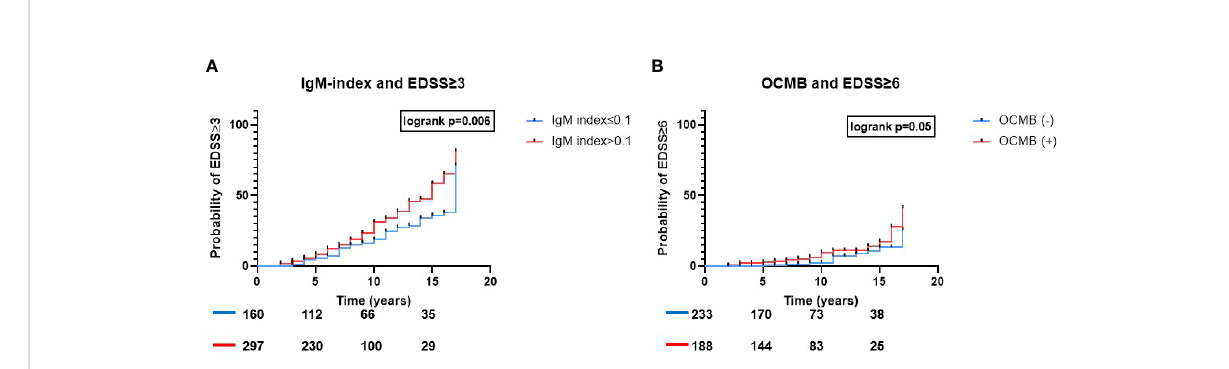
FIGURE 3 ITMS and risk of reaching disability milestones. Association of ITMS and risk of rising disability. Kaplan-Meier survival curves and results of the logrank test results for (A) IgM-index>0.1 and probability of reaching EDSS ≥ 3 and (B) OCMB and probability of reaching EDSS ≥ 6. Ig, immunoglobulin; EDSS, expanded disability status scale; OCMB, oligoclonal IgM